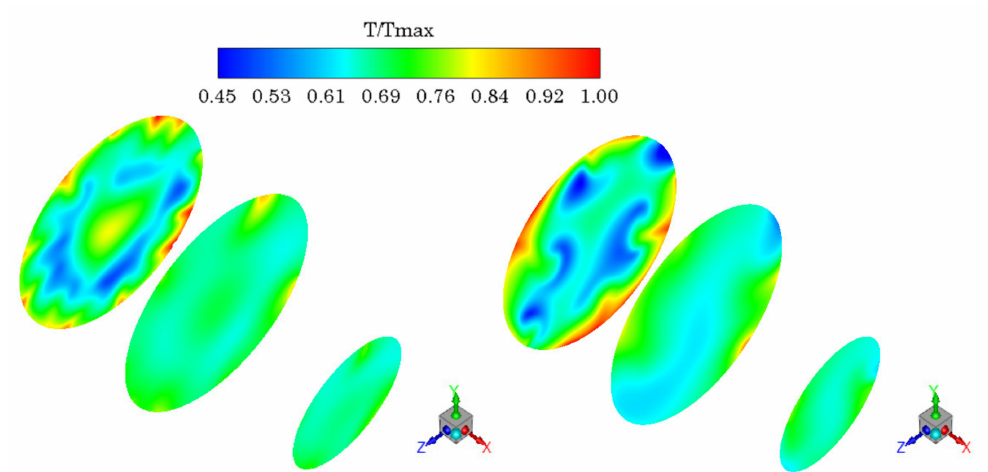
Figure 12. Temperature fields downstream of the dilution holes for Conf A ( left ) and Conf B ( right ) at different planes along the combustor axial